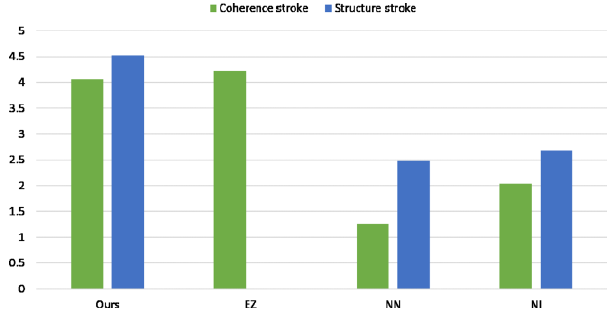
Fig. 12 Average scores of different methods in the user study (the higher, the better).